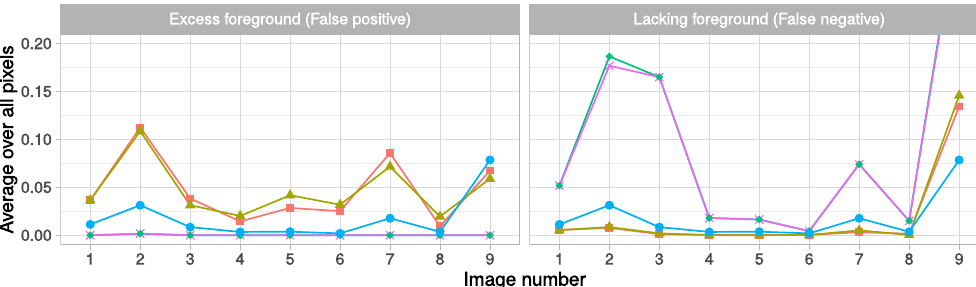
All methods performed relatively well in terms of precision and did not falsely identify many background pixels as foreground (Fig. 6). The methods based on local entropy were more liberal in this regard, whereas the methods applied to the raw data remained very conservative. This conservatism was reflected in the FNR, where these two reference methods were in some cases having difficulties to capture the full foreground. The expert average FPR and FNR revealed that some images, namely 2, 7 and 9, were significantly more difficult to seg- ment than the others and the expectations placed on the automated methods should thus be relaxed accordingly. Overall, the methods that included the local entropy filtering were preferable, despite the moderately increased FPR. Although the differences between the two candidates were not as pronounced, the method utilizing the Otsu’s threshold arguably provided the best overall results. The chosen method has an overall good performance with both the FPR and FNR below 10% in every image, except the very difficult image number 9. Local texture features allow accurate classification of the PDX microtissues. The two cell types, tumor cells and fibroblasts, typically form complex, interlaced superstructures (Fig. 4). Depending on their gen- otype and stimuli provided by their microenvironment, the tumor cells generally form organoids that can be either rounded or form grape like structures, in some cases even “stellate” structures with invasive “appendages”. In contrast, the fibroblasts are typically loosely grouped, rarely form cell clusters, and stretch out to form a more or less dense meshwork of cells throughout the entire cell culture area. Without any additional color labels to sep- arate the cell classes from each other, and only gradual differences in live cell labeling via exposure to the Calcein AM dye, we cannot expect direct and simple segmentation approaches such as the method utilized by Di et al . 33 to yield convincing results. Therefore, we first split the obtained image foreground into disjoint regions, which we then aimed to accurately classify into either the fibroblast/CAF or tumor cell type in a supervised manner (Fig. 3 middle). Conventional segmentation techniques, such as those used in 23, 34 , can then be applied to the labeled foreground, and allow a straightforward analysis of multicellular (tumor) or individual (fibroblast) cell structures. In addition to the nine detailed ground truth images, a set of 18 only roughly segmented images curated by just one expert, was added to increase the size of the classifier training set to 27 images. These additional training images separate the foreground into the two cell types, but do not accurately portray the boundaries of multi- cellular structures. Generating such training material was relatively straightforward and fast, thus allowing the classifier to be retrained for new data with manageable effort. In the PDX microtissues, single, most likely dead and/or apoptotic cells demonstrated a small and round phenotype regardless of their cell type. Differentiating between fibroblast and tumor cells in these cases was not attempted; and it is likely that both cell types are presented in this group. Instead, small objects with a maximum diameter of less than 30 pixels and roundness of at least 0.5 (50% roundness compared to ideal sphere) were excluded from the training and simply labelled as “rounded single cells”. However, these data were not excluded from the subsequent analyses, but were displayed as a third class of cells. The roundness measure is defined in detail later in the section describing the statistical analyses. After the removal of single “dead” cells, the foreground of the 27 training images was identified using the pro- posed thresholding method and then split into individual disjoint Voronoi regions, using a propagation algorithm described by Jones et al . 35 . Importantly, the regions obtained with this algorithm respect the borders of the fore- ground but their general shape and size can be controlled via the supplied seed pixels of the regions. For optimal segmentation results, the regions should be large enough to retain the amount of information necessary for the classification, but still small enough to allow accurate segmentation. Here, we opted to use hexagonal regions of approximately 350 pixels, roughly the size of one large cell or a small multicellular structure. An example of the resulting (and classified) regions is shown in Fig. 4. A total of 2851 regions labeled as “fibroblast” and 2739 as “tumor” were obtained from the 27 images. The ground truth labels for the regions were decided with a majority vote over the manually labeled images: the total number of pixels colored as cancer and as fibroblast in the region across all ground truth images was calculated, after which the label of the region was set to which ever total was higher. For the large majority of the regions (85%), the decision was close to unambiguous with one of the two labels getting over 90% of the votes. A set of 37 numerical features describing the texture of each region was extracted: